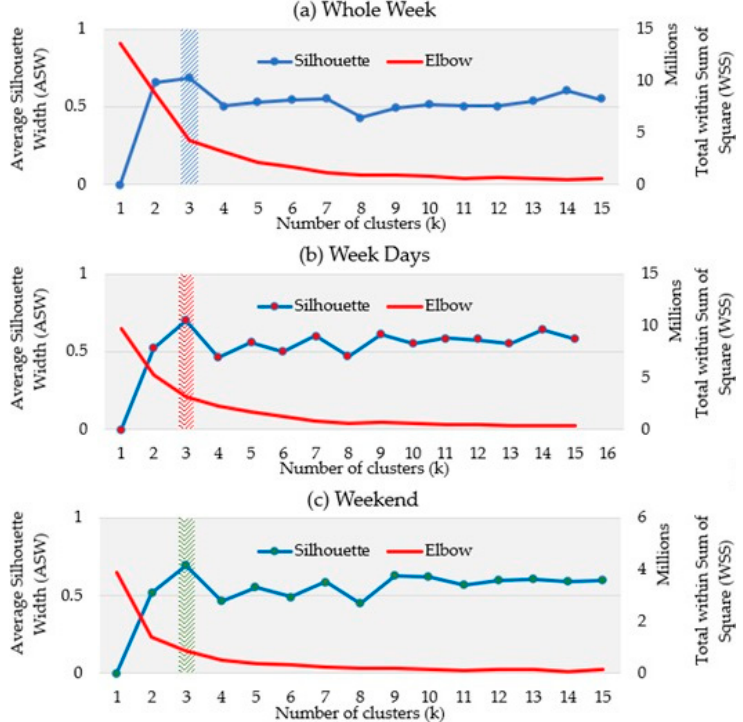
Figure 4. Elbow method vs. silhouette method. ( a ) Results for the whole week scenario; ( b ) results for the week days scenario; ( c ) results for the weekend scenario.